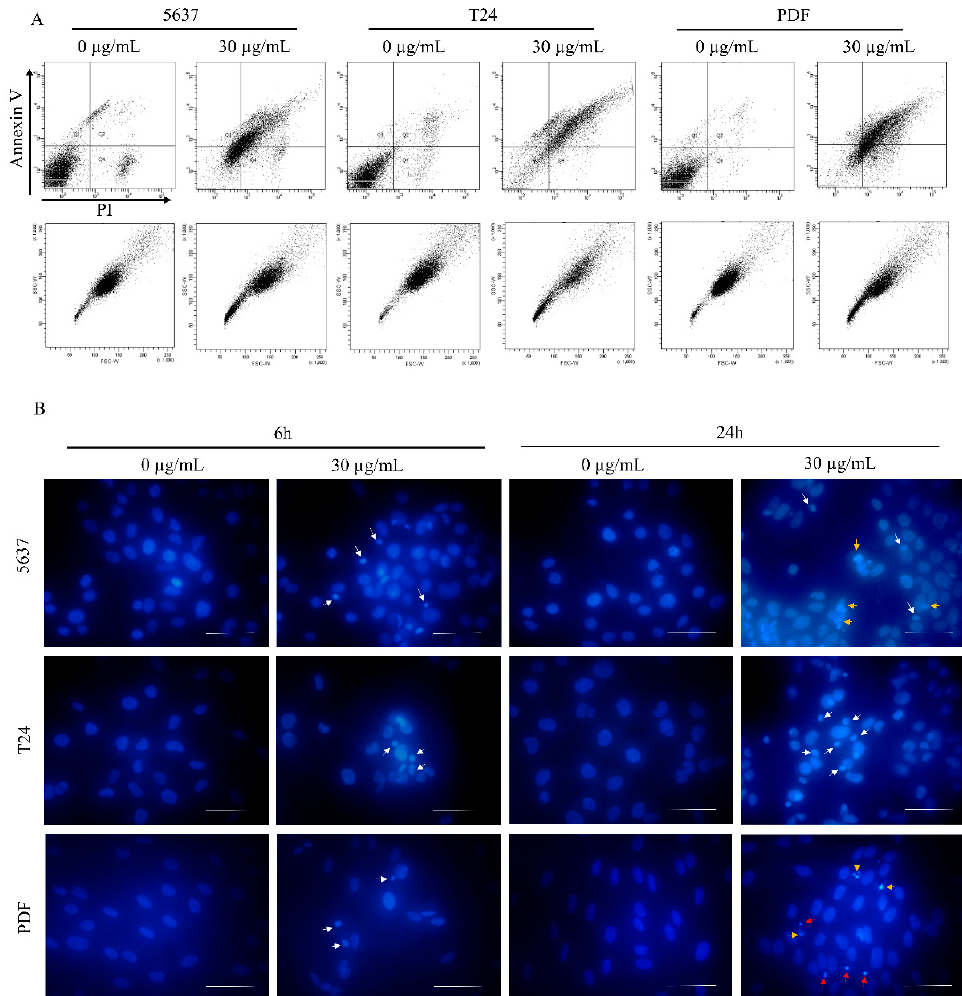
Figure 6. Cell death type assessment. ( A ) Flow cytometry analysis of 5637, T24 and PDF cells treated with star polymer for 6 h using Annexin V and Propidium Iodide staining. ( B ) DAPI-stained nuclei of 5637, T24 and PDF cells after treatment with star polymer for 6 h at the concentration 30 µ g/mL. Condensed nuclei are indicated by white arrows, fragmented by yellow arrows and highly condensed nuclei by red arrows. Scale bars represent 50 µ